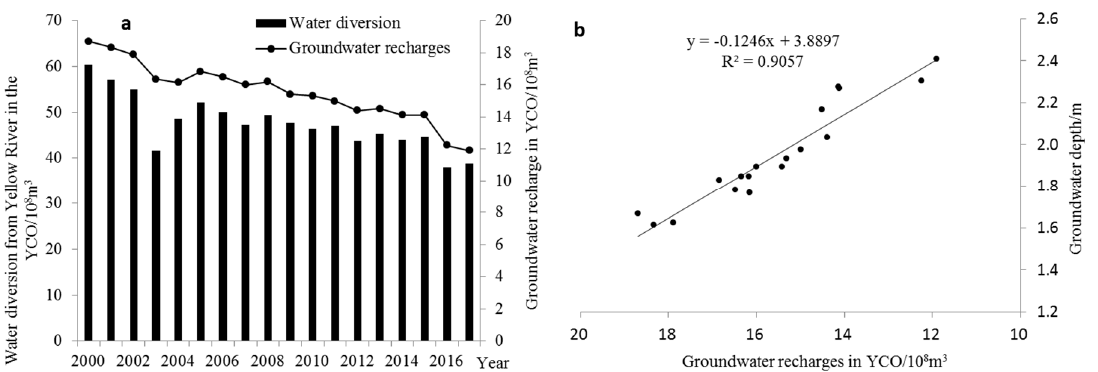
Figure 6. ( a ) Groundwater recharges variation with water diversion in the YCO, ( b ) relationship between groundwater recharge and groundwater depth.